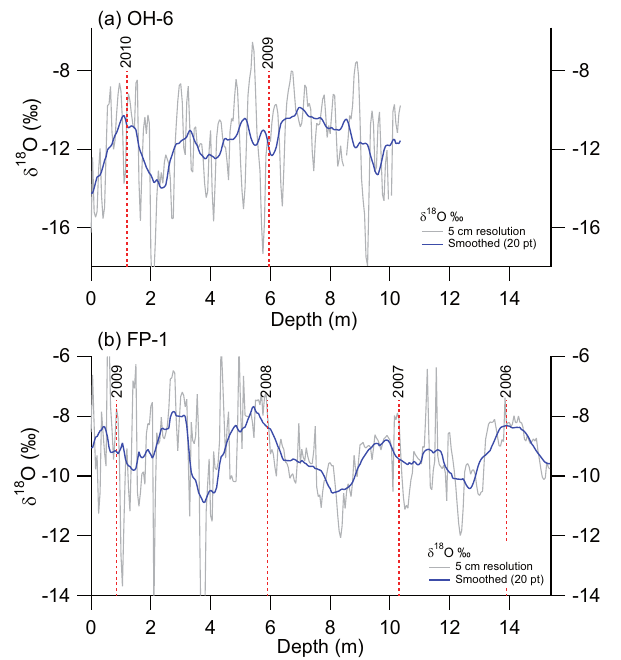
Fig. 9. High resolution (5cm, light grey lines) and smoothed (20 points, blue line) δ 18 O signal of firn cores: (a) OH-6 and (b) FP- 1. OH-6 was retrieved from Laclavere Plateau (Antarctic Peninsula) in 2010; FP-1 was retrieved from the main dome of King George Island (South Shetland Islands), in 2009. Note that none of the cores show defined seasonal cycles, as seen from the year of depo- sition. The first day of the year is approximately indicated (dashed red lines).